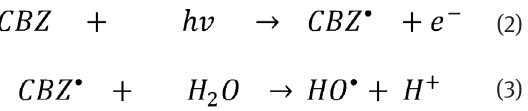
Figure 6 : Scan LC/MS analysis of CBZ intermediates in the CPC (initial CBZ concentration 3 mg/L, the solar irradiation time of 3 h and initial pH value of 9).